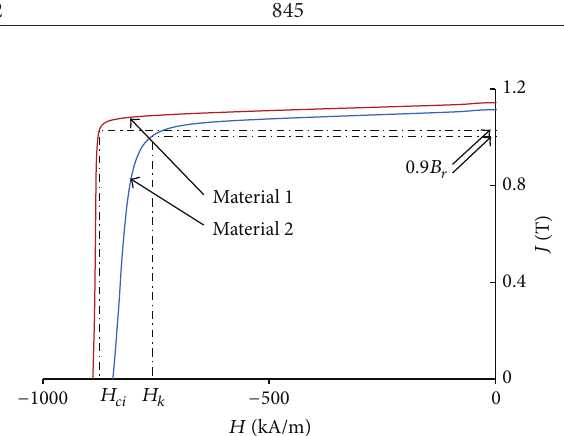
Figure 3: JH curves measured at 100 ∘ C for materials 1 and 2 with an elucidation of the squareness factor determination.